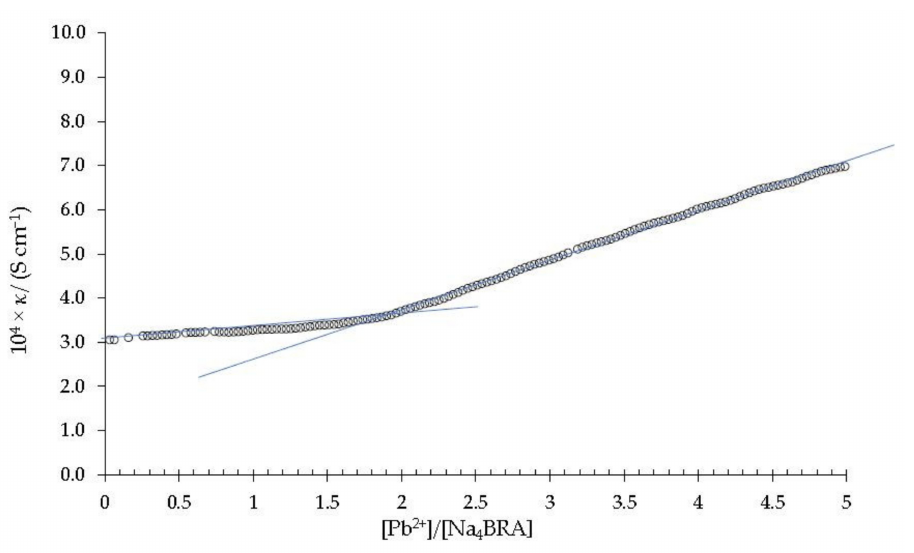
Figure 5. Specific conductivity versus the [Pb 2+ ]/[Na 4 BRA] ratio. The solid blue lines are shown as a visual aid to indicate the cut-off point that relates the change in slope of the specific conductivity with respect to the stoichiometry of the